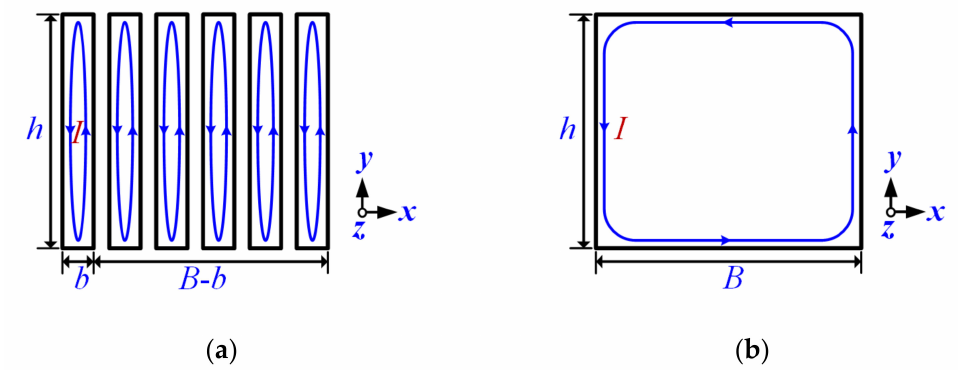
Figure 9. Sectional view of current flow in the original model and equivalent model. ( a ) Ribbons with homogeneous conductivity, ( b ) Homogeneous core with orthotropic conductivity and permeability. ( h is width of the ribbon, b is thickness of a single ribbon, B is thickness of the solid conductor, and I is the magnitude of eddy current in magnetic